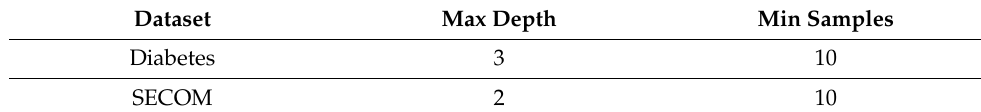
Table 2. Decision tree training hyper-parameters for the AutoDT.